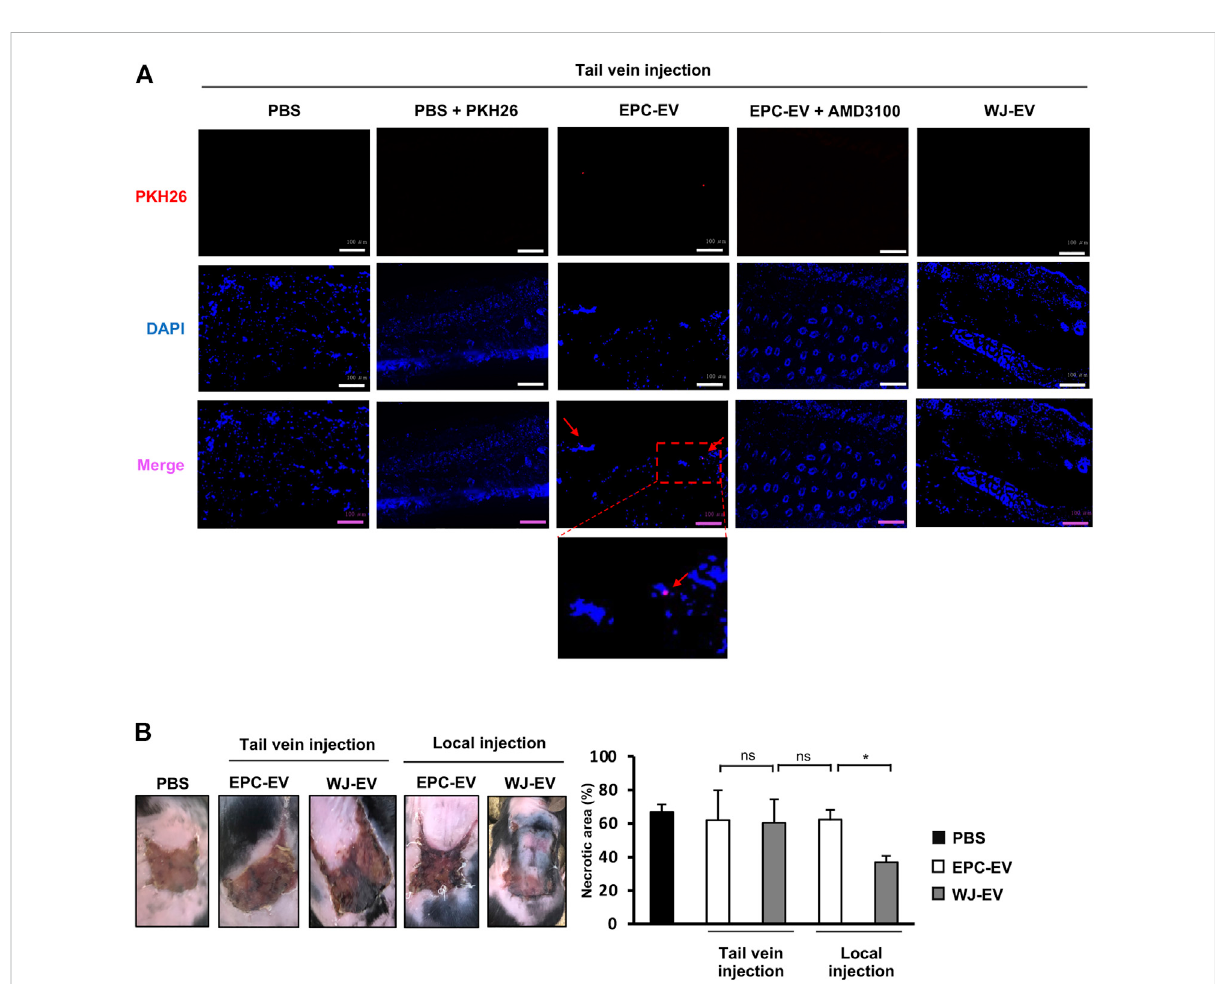
FIGURE 1 EPC-EV were uptaken at the injured sites but showed poor ability to rescue the ischemic tissues in the intravenous injection (A) . The fl uorescence imaging analysis of PKH26-labeled EV at 24 h after tail vein injection. EPC-EV + AMD3100: PKH26-labeled EPC-EV treated with CXCR4antagonistAMD3100.Anamountof60 µgPKH26-labeledEPC-EVinPBScontainingAMD3100(Sigma-Aldrich)ataconcentrationof100 nM was injected into the fl ap mice via tail veins. Photos were captured under a microscope at ×20 magni fi cation. Bars indicate 100 µm ( n = 3). The experimentswereperformedtriplicated (B) .Thenecroticareaofischemic fl apmicewithtailveinandlocalinjectionofEPC-EVorWJ-EV( n =9).The data represent the mean ± SD. ** p < 0.01, * p < 0.05, ns: no signi fi